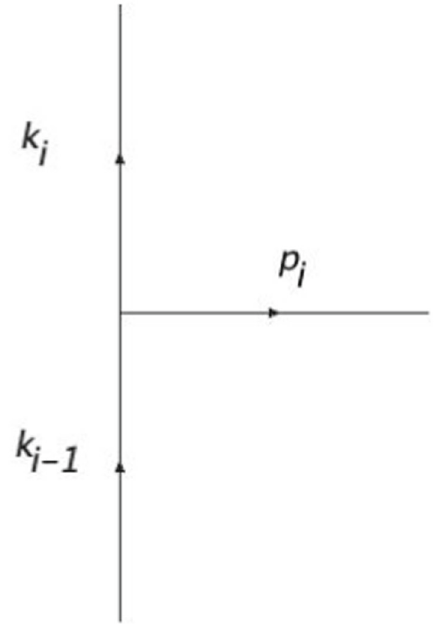
Fig. 1 Parton branching